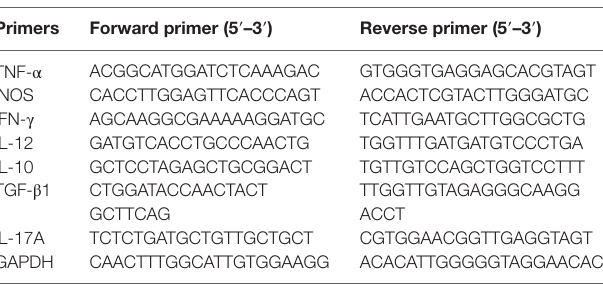
TaBle 2 | The primers used for